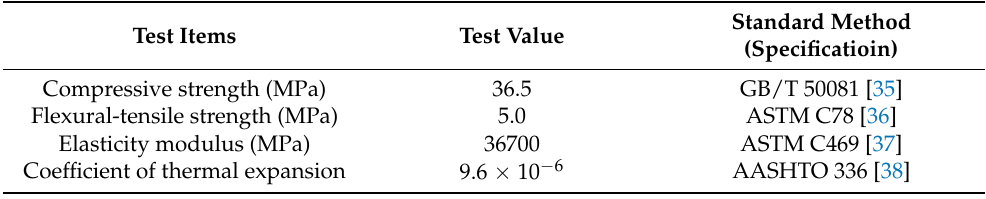
Table 3. Properties of rubberized concrete.